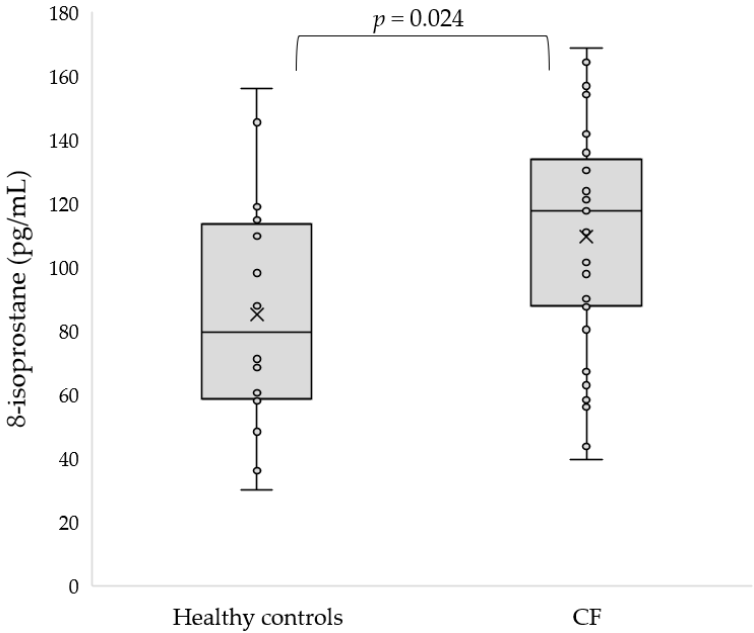
Figure 3. Concentration of 8-isoprostane in serum of CF patients as compared to the control group.